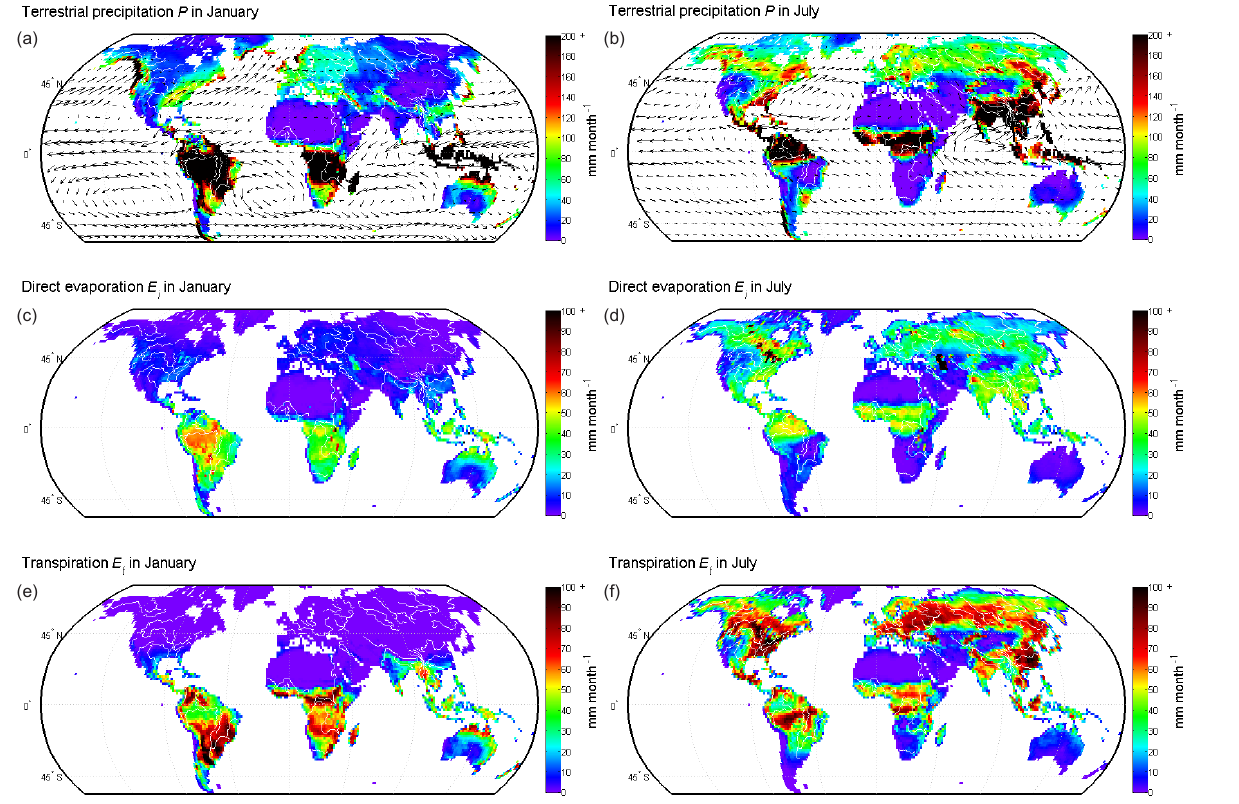
Figure A2. Precipitation and evaporative fluxes for January (left column) and July (right